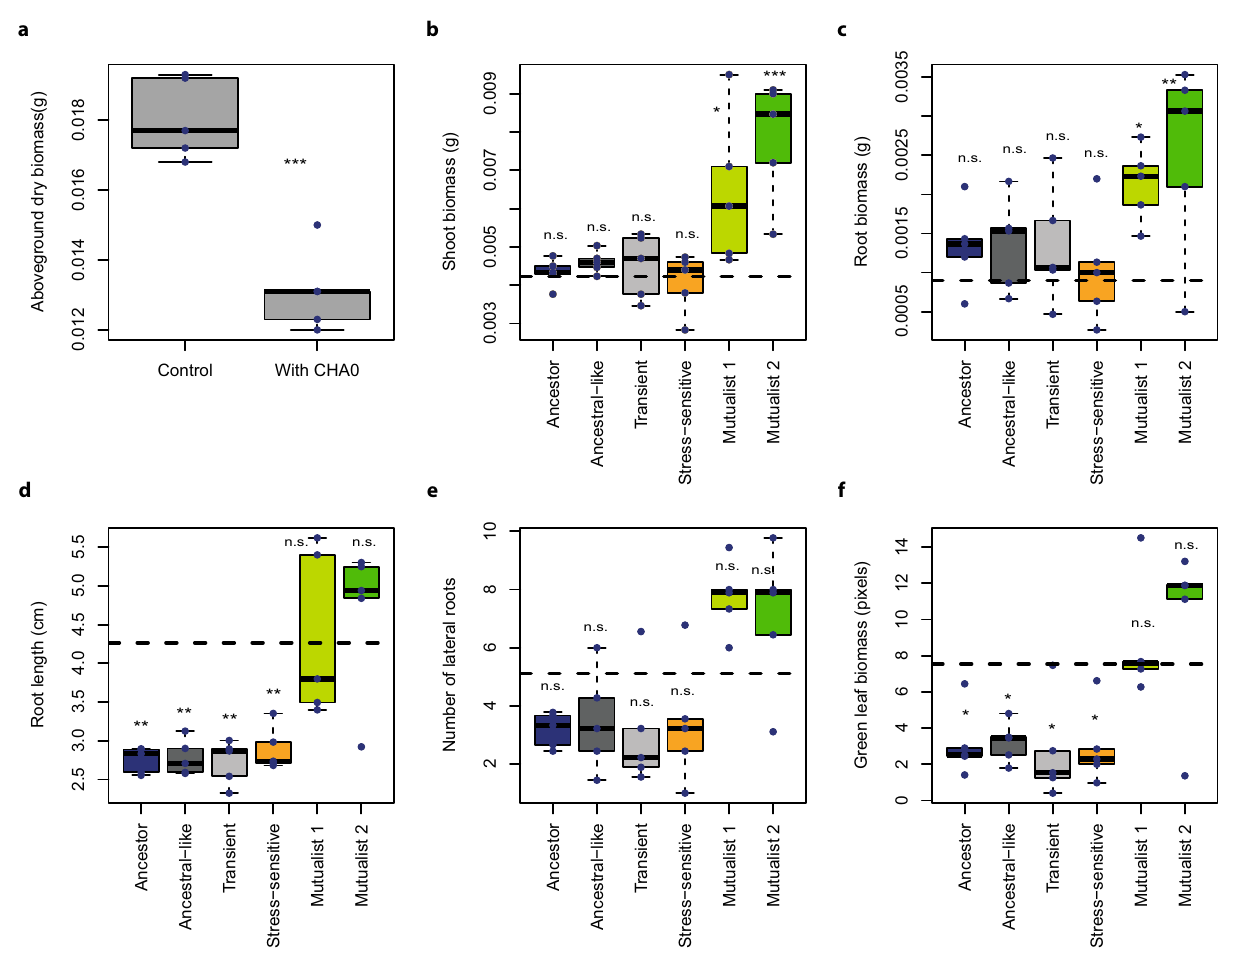
Fig. 1 Evolution of bacterial mutualism in the rhizosphere of Arabidopsis thaliana . Panel a shows the initially antagonistic effect of Pseudomonas protegens CHA0 on A. thaliana after one plant growth cycle in the sterile sand study system ( n = 5; aboveground biomass *** P = 0.0001). Panels b – f compare the effects of ancestral and evolved Pseudomonas protegens CHA0 phenotypes on plant performance-related traits in a separate plant growth assays performed on agar plates at the end of the selection experiment ( n = 3 for control and n = 5 for each evolved phenotype, see Table S2). Different panels show the shoot biomass in grams ( b ), root biomass in grams ( c ), number of lateral roots ( d ), root length in cm ( e ), and the amount of plant ‘ greenness ’ in terms of green-to-white pixel ratio ( f ) after 14 days of bacterial inoculation (Supplementary Data 2; blue dashed horizontal lines show the non-inoculated control plants). Bacterial phenotype groups are displayed in different colours (black: ancestor; dark grey: ancestral-like; light grey: transient; orange: stress- sensitive, light green: mutualist 1 and dark green: mutualist 2) and were classi fi ed and named based on K -means clustering (Fig. S1) using 14 phenotypic traits linked to growth, stress tolerance, production of bioactive compounds and antimicrobial activity (Table S1). All boxplots show median (centre line), interquartile range (25 – 75%) and whiskers that extend 1.5 times the interquartile range overlaid with a scatter plot showing independent replicates. Statistical testing in all panels was carried out using one-way ANOVA, and asterisks above plots indicate signi fi cant differences between control and bacteria-treated plants (* P = 0.05, ** P = 0.01, *** P = 0.001; n.s. = non-signi fi cant). Data for all panels are provided in the Source Data fi end of the sixth growth cycle (Fig. 2a), while the ʻ Stress-sensitive ʼ phenotypes reached higher abundances in the plant rhizosphere phenotypes emerged only in three selection lines and survived compared to other phenotypes (bacterial cells per plant). This until the end of the experiment only in one of the selection lines indicates that reduced bacterial antagonism towards the plant was (Fig. 2a). In contrast, the frequency of mutualistic phenotypes increased in four out of fi ve plant selection lines throughout the experiment, while one selection line became dominated by ʻ Ancestral-like ʼ and ʻ Stress-sensitive ʼ phenotypes (Fig. 2a). An aggregated ʻ plant performance ʼ index summarising the effects of each bacterial isolate on both aboveground and belowground plant growth traits (Fig. 2b, PC1 of multivariate analysis) was used to explore if reduced antagonism towards the plant was associated with improved bacterial growth indicative of the evolution of a reciprocally bene fi cial mutualistic interaction. We found a signi fi cant positive correlation between plant performance index and bacterial phenotype abundance per plant ( F 1, 28 = 8.01, P < 0.001, Fig. 2c). Speci fi cally, both mutualistic